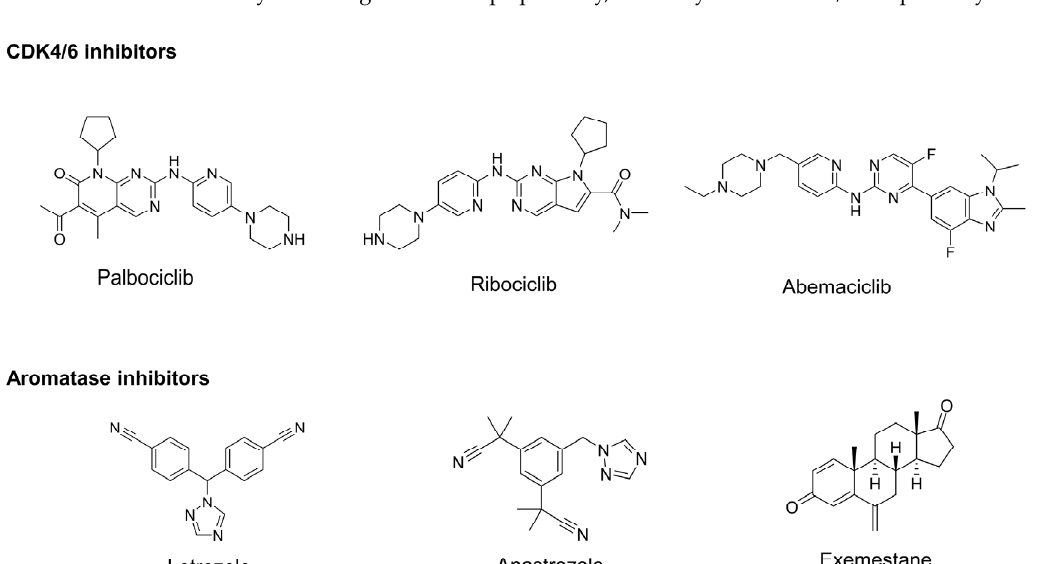
Figure 2. A schematic illustration of the functional relationships between aromatase and CDK4/6 inhibitors. The ER pathway is directly targeted by aromatase inhibitors, while CDK4/6 inhibitors work by inhibiting the ER escape pathway, or the Cyclin D-CDK4/6-Rb pathway.